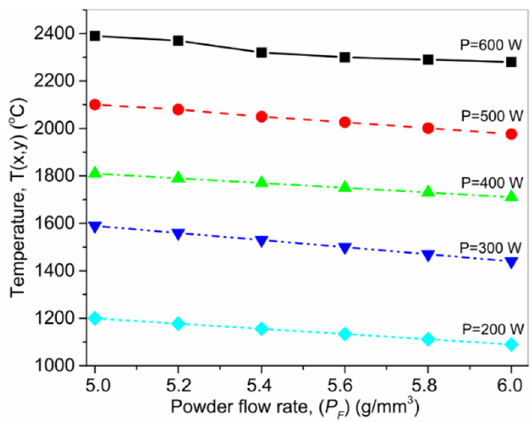
Figure 10. Effect of Ti6Al4V alloy powder flow (P F ) and laser power (P) on the average maximum temperature of the substrate.